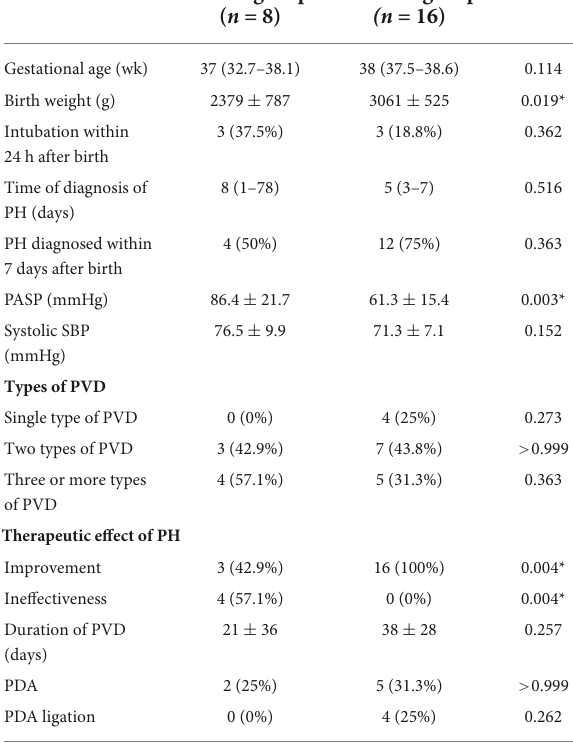
TABLE 3 Comparison of clinical outcomes of the study cohort by the presence of PH.